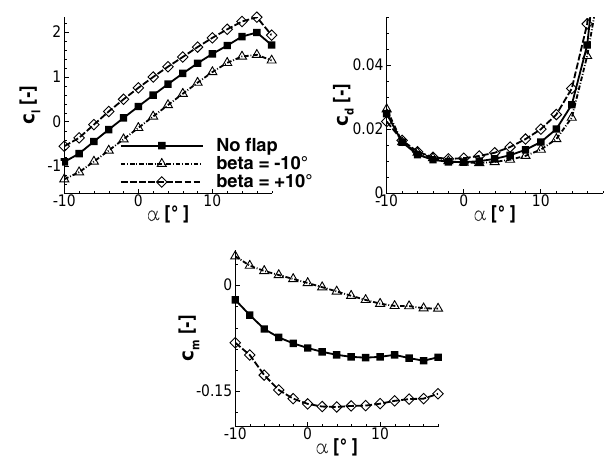
Figure 1. Example of flap deflection on c l , c d and c m (FFA- w3-241 airfoil, Reynolds number Re = 15 . 57 × 10 6 , Mach number M = 0 .